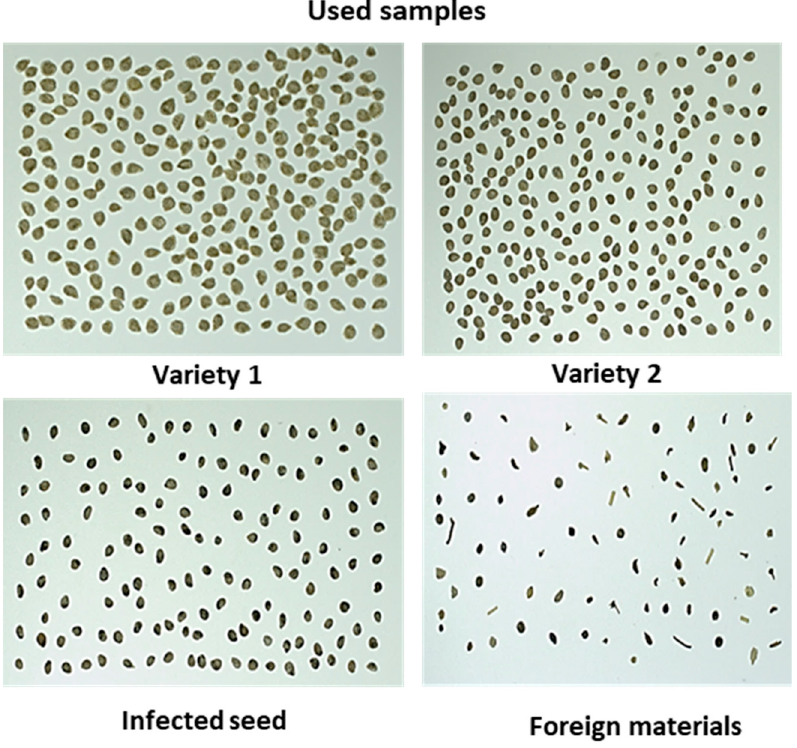
Figure 1. Samples used to build the model.